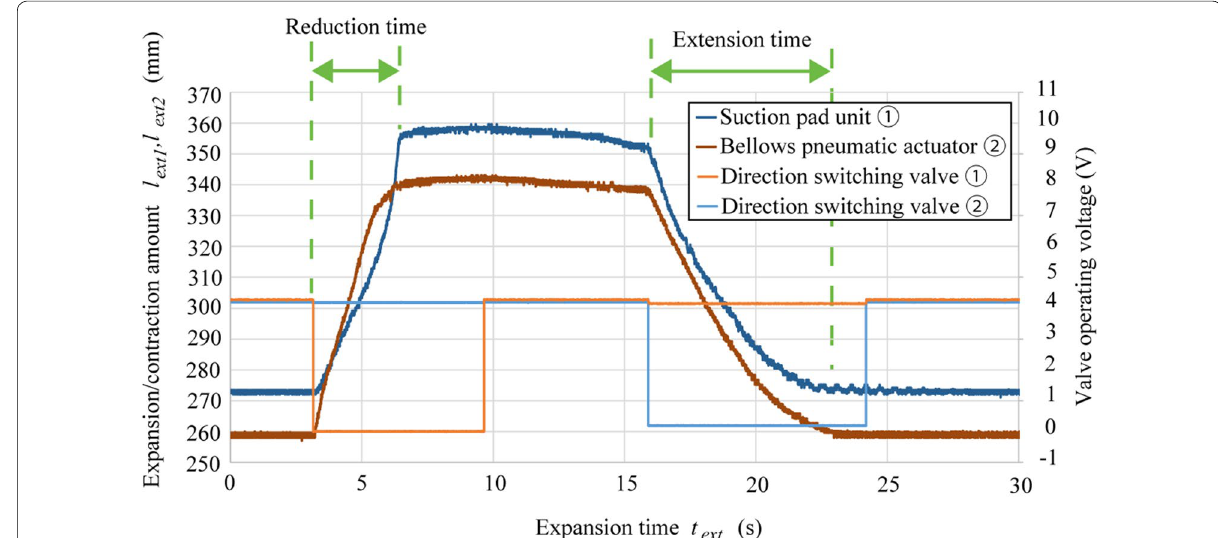
Fig. 41 Experimental results from the expansion and contraction motion evaluation